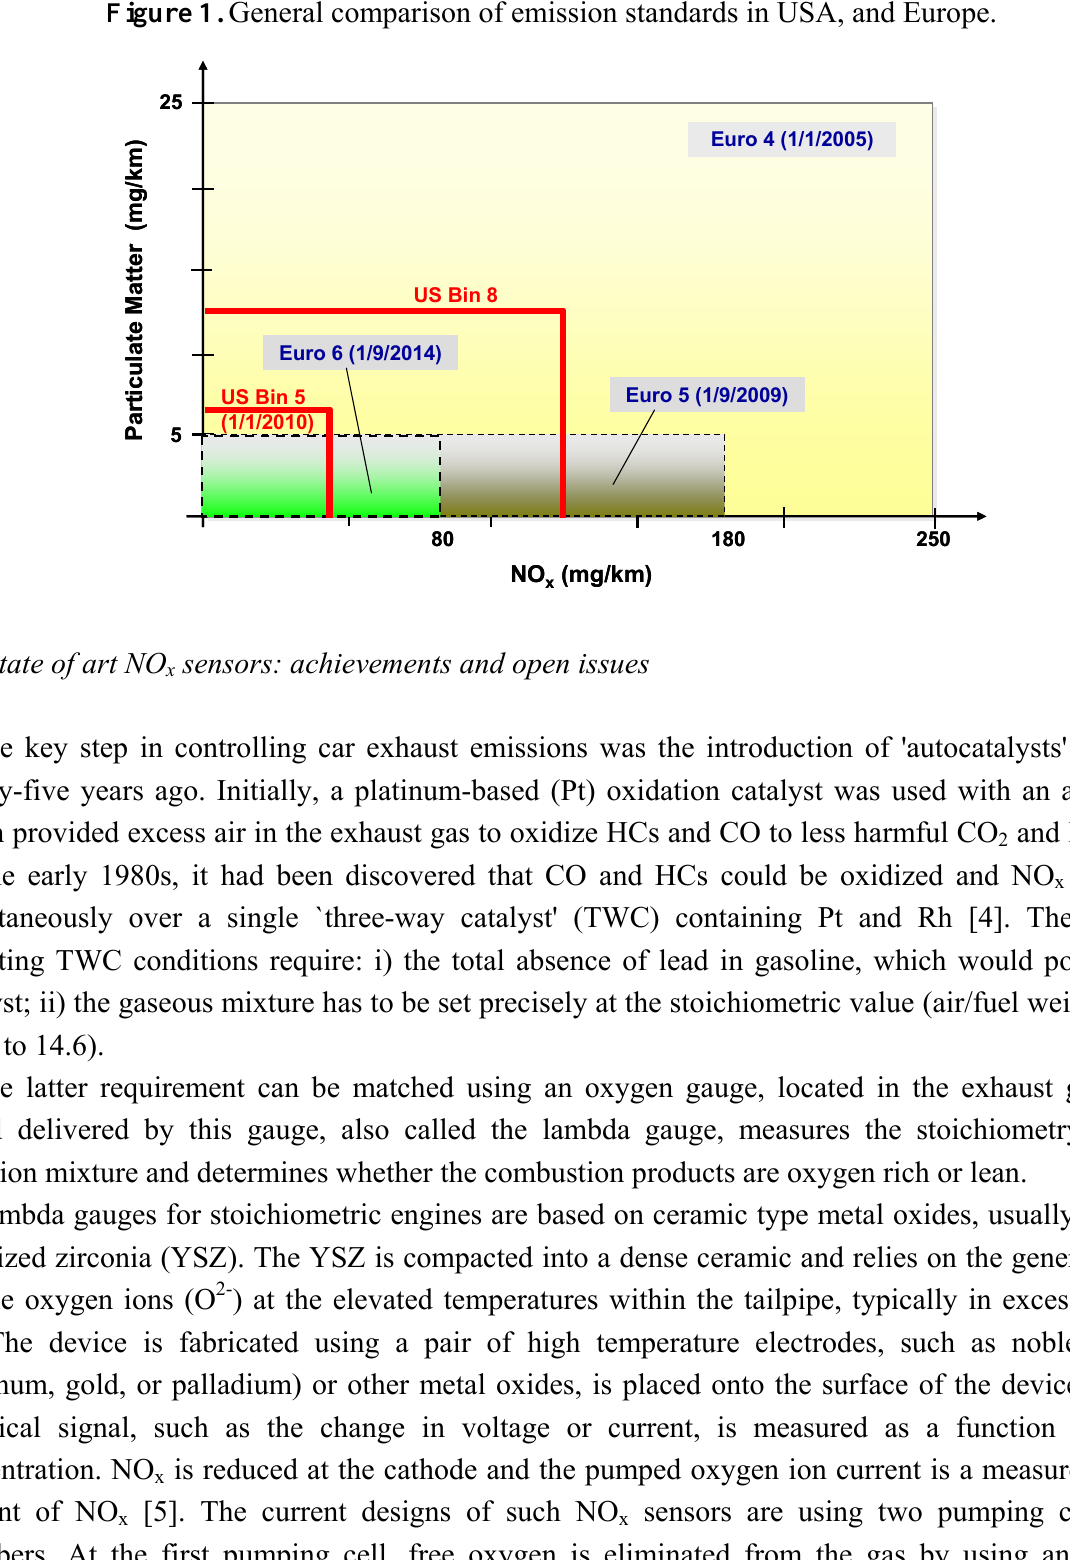
Figure 1. General comparison of emission standards in USA, and